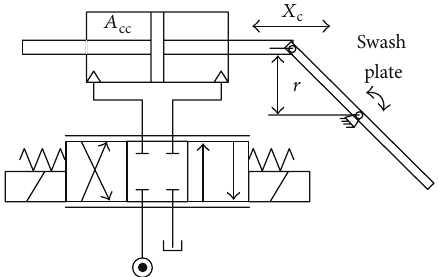
Figure 6: Displacement control mechanism of the main pump and